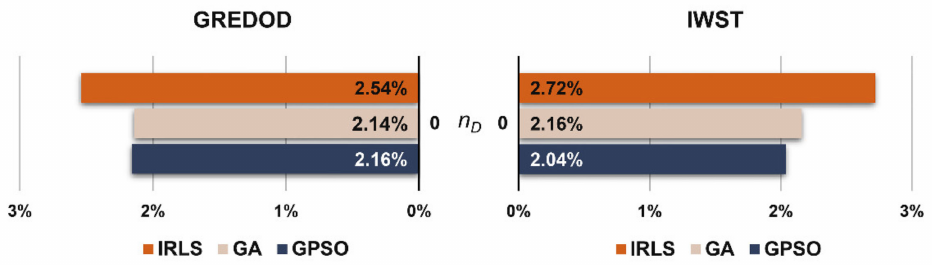
Figure 7. FPRs of GREDOD and IWST